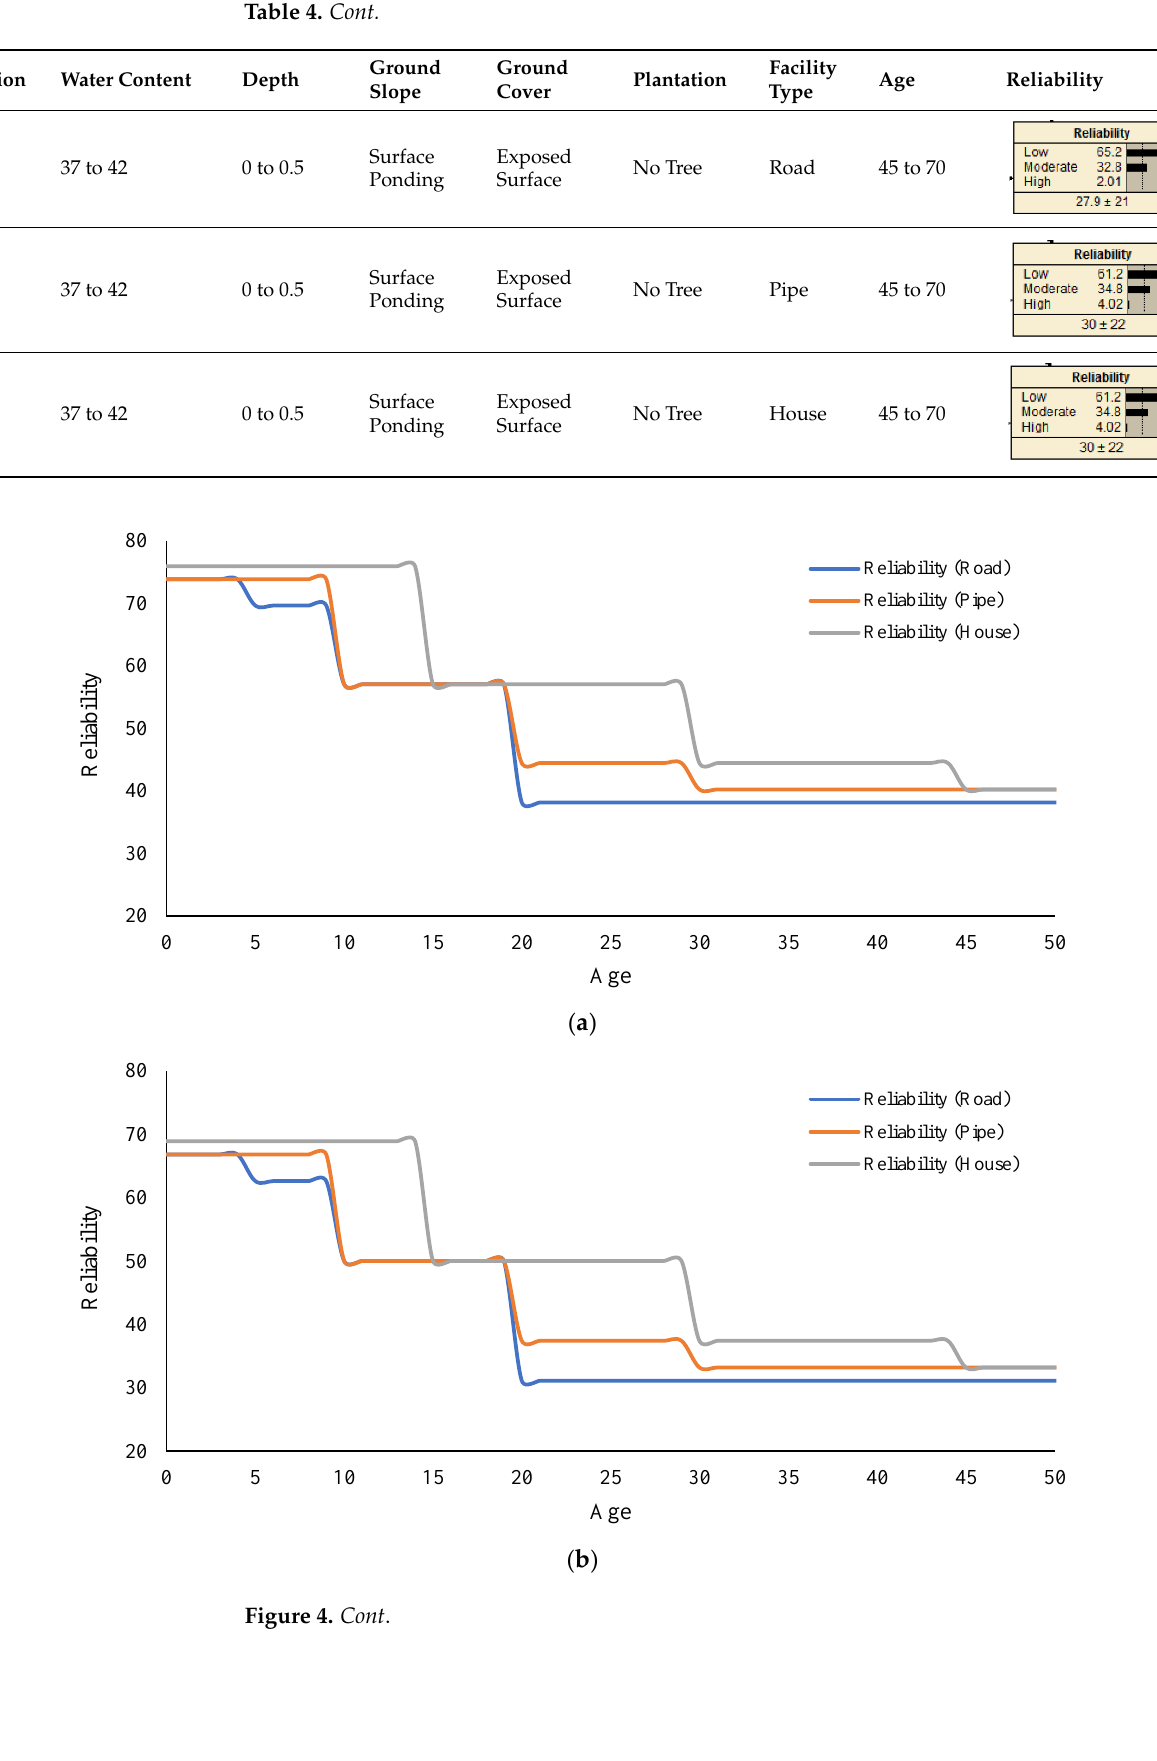
7 Table 3. Summary of sensitivity analysis.